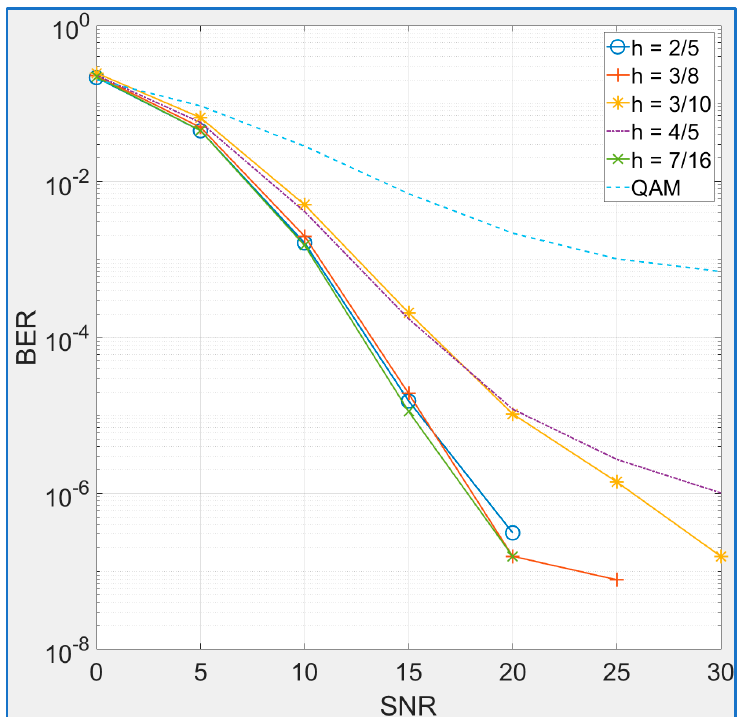
Figure 14. BER performance of CPM-GFDM vs. QAM-GFDM with 𝐽 = 4 for matched filter receiver over frequency-selective channels.